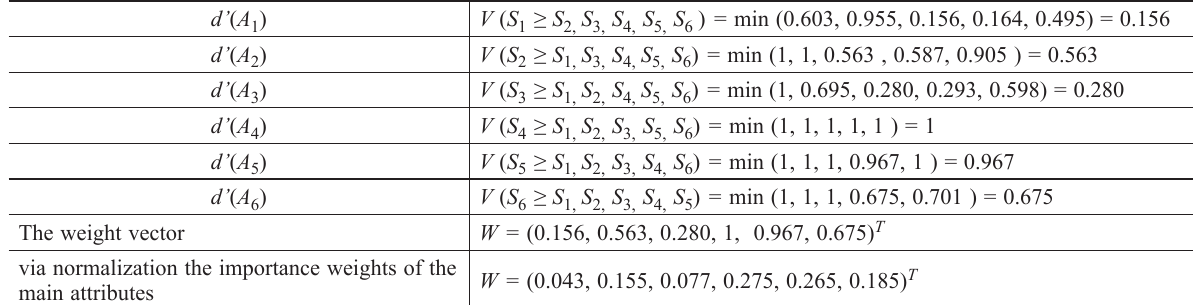
Table 6. The minimum degree of possibility for the example of the pairwise comparisons of criteria with related to